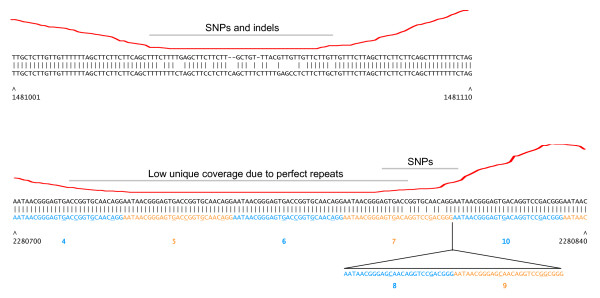
Details of B. anthracis polymorphisms not detected by the SOLiD™ system. Sequence alignments of B. anthracis Sterne (top line) versus Ames ancestor (bottom line). Red line indicates coverage depth of uniquely mapping A2012 SOLiD™ system reads at each position. Sterne chromosomal coordinates are given below the alignment. (Top) A region of high SNP density (13 SNPs in 40 bp) and small indels in GBAA_2450. (Bottom) In GBAA_1572, SNPs occur in a region containing a 27 bp repeat (alternating blue and orange blocks, with repeat number below). Relative to Ames ancestor, the Sterne genome lacks two repeat units. The four SNPs are adjacent to the indel breakpoint. Low unique coverage to the left of the SNPs is due to three perfect repeats (numbers 4, 5 and 6). Bases that differ from the consensus sequence are underlined.